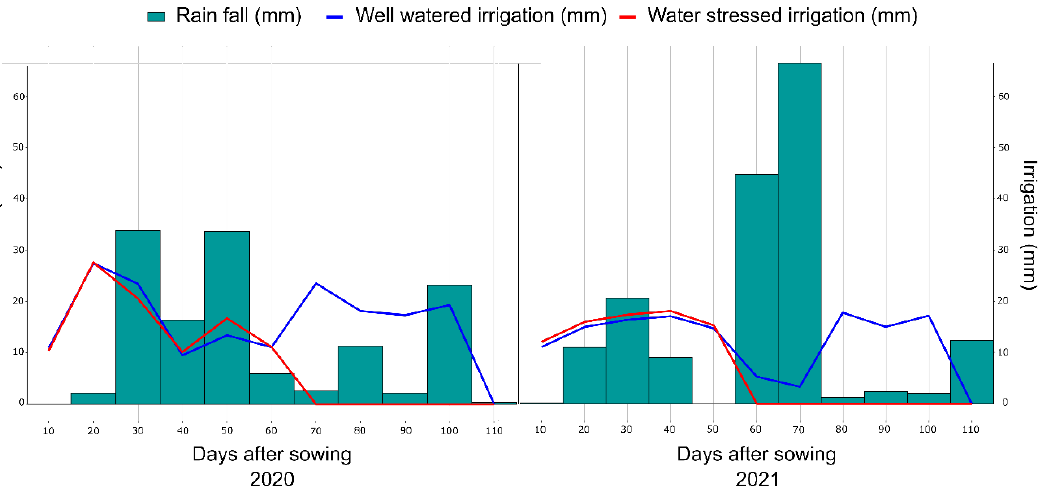
Figure 7. Amount of water applied (mm), in the 2020 and 2021 crop seasons, concerning the days after sowing of popcorn lines. WW (well-watered) and WS (water stress condition). The red line refers to the WS condition, and the blue line refers to the WW